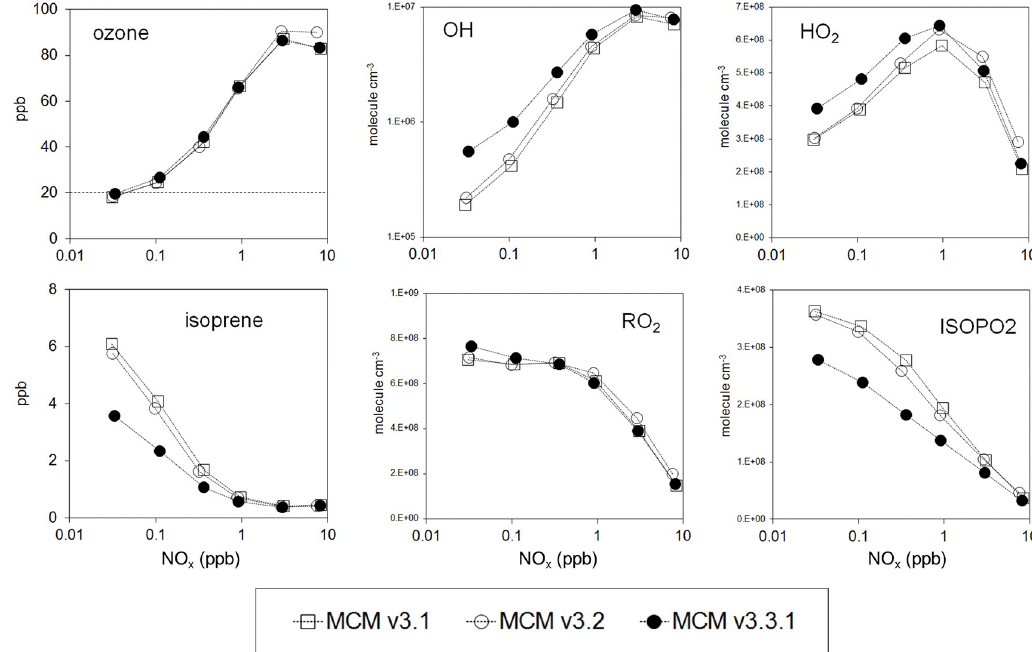
Figure 10. Comparison of performances of MCM v3.1, MCM v3.2 and MCM v3.3.1, showing the NO x dependence of the daylight-averaged mixing ratios or concentrations of O 3 , isoprene, OH, HO 2 , total organic peroxy radicals (RO 2 ) and peroxy radicals formed from the first- generation OH-initiated chemistry (ISOPO2). The broken line in the O 3 panel shows the background mixing ratio relative to which O 3 is either produced or destroyed (see text).